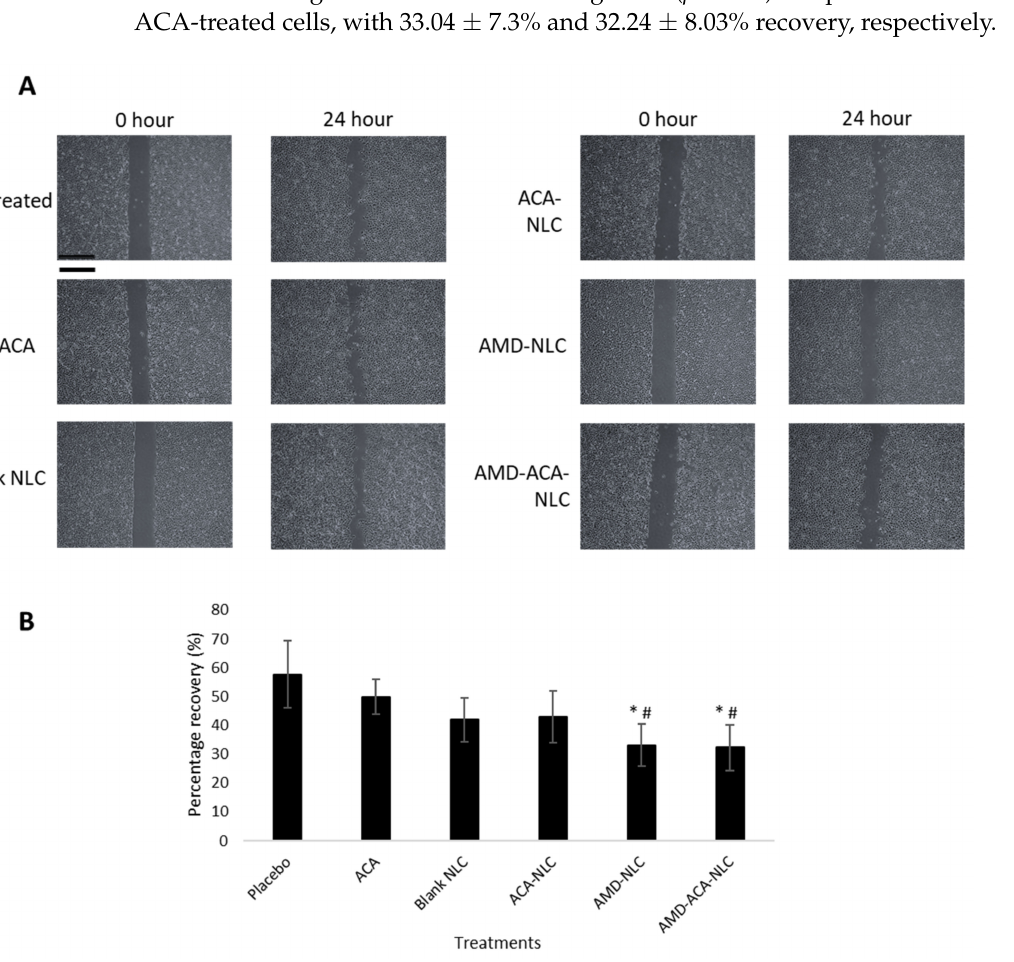
Figure 6. Migration assay conducted on PC-3 cell lines without treatment or with ACA, blank NLC, ACA-NLC, AMD-NLC, and AMD-ACA-NLC treatments. ( A ) Representative images of wound healing assays. Scale bar = 200 µ m. ( B ) Percentage recovery of wounds after different treatments. Significant differences in area migrated by cells in comparison to the untreated and ACA-treated cells are marked with * p < 0.05 and # p < 0.05, respectively. All data are shown as mean ± S.D. of three independent